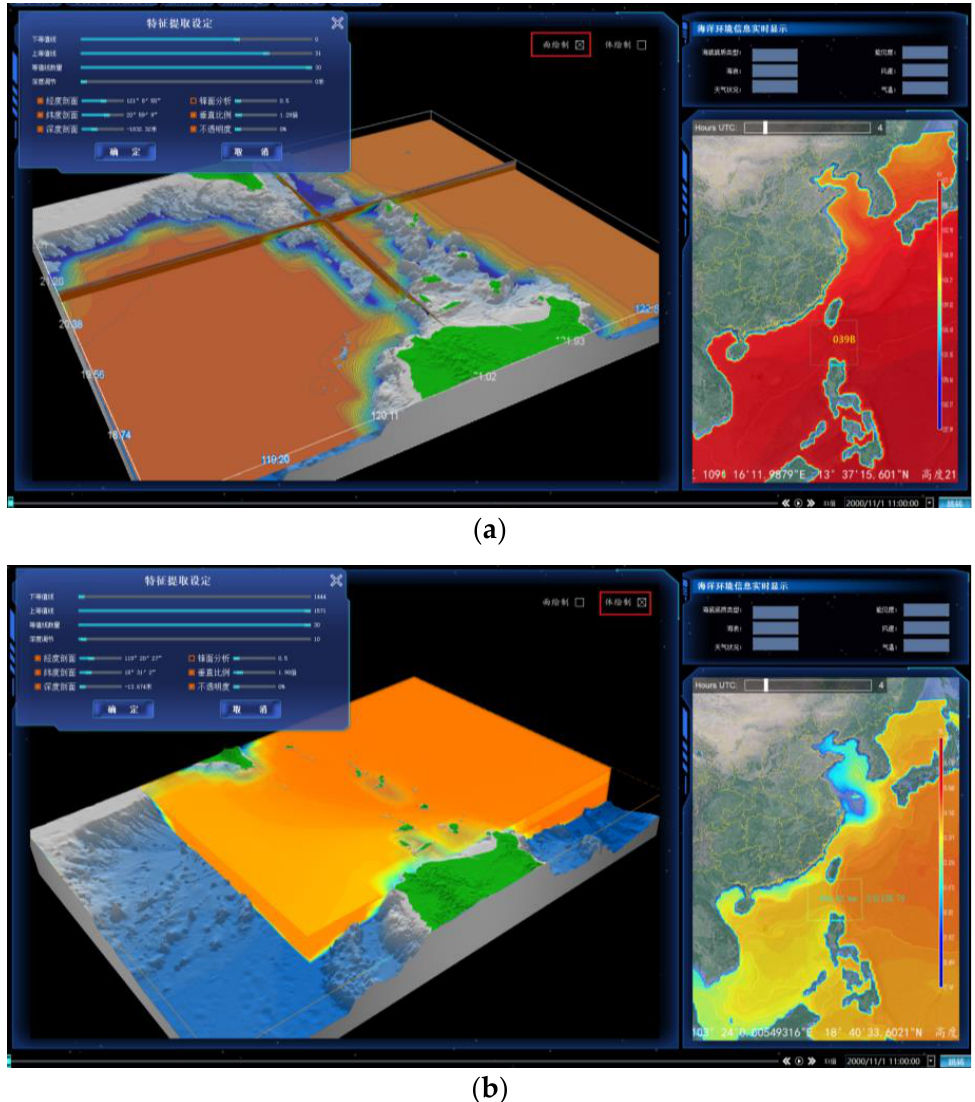
Figure 16. Local analysis renderings (( a ) is surface rendering, ( b ) is volume rendering).